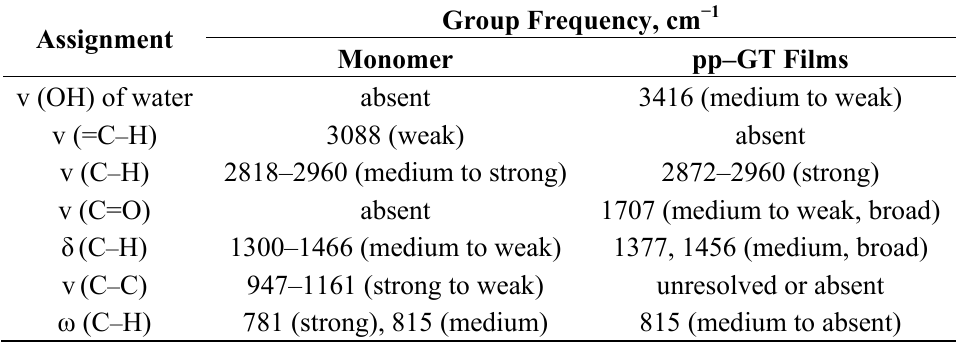
Table 1. FTIR assignments for γ -Terpinene monomer and plasma- polymerized γ -Terpinene (pp–GT) films, adapted from